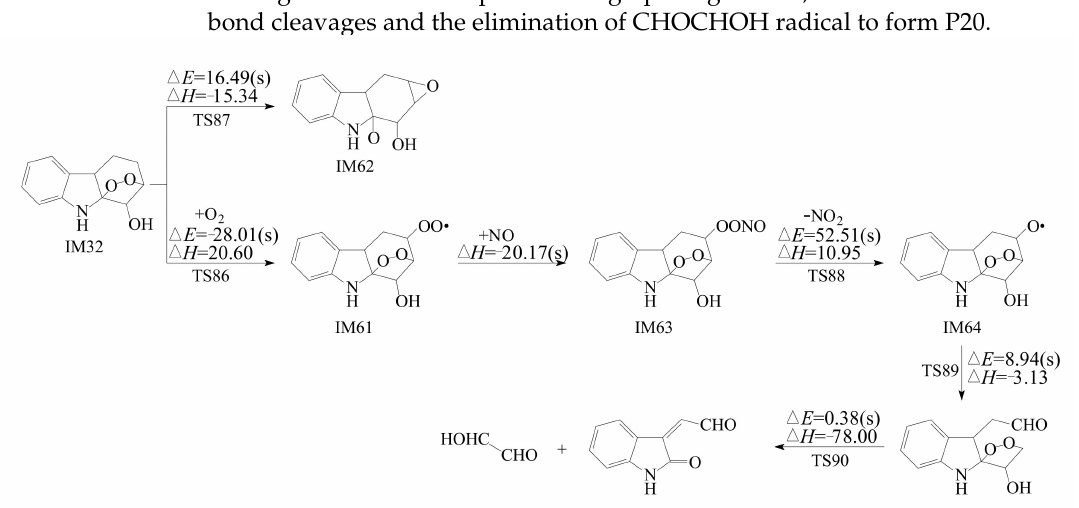
Figure 8. The reaction scheme of IM32 embedded with the potential barriers ∆ E (in kcal mol − 1 ) and reaction heats ∆ H (in kcal mol − 1 , 0 K) in the presence of NO and O 2